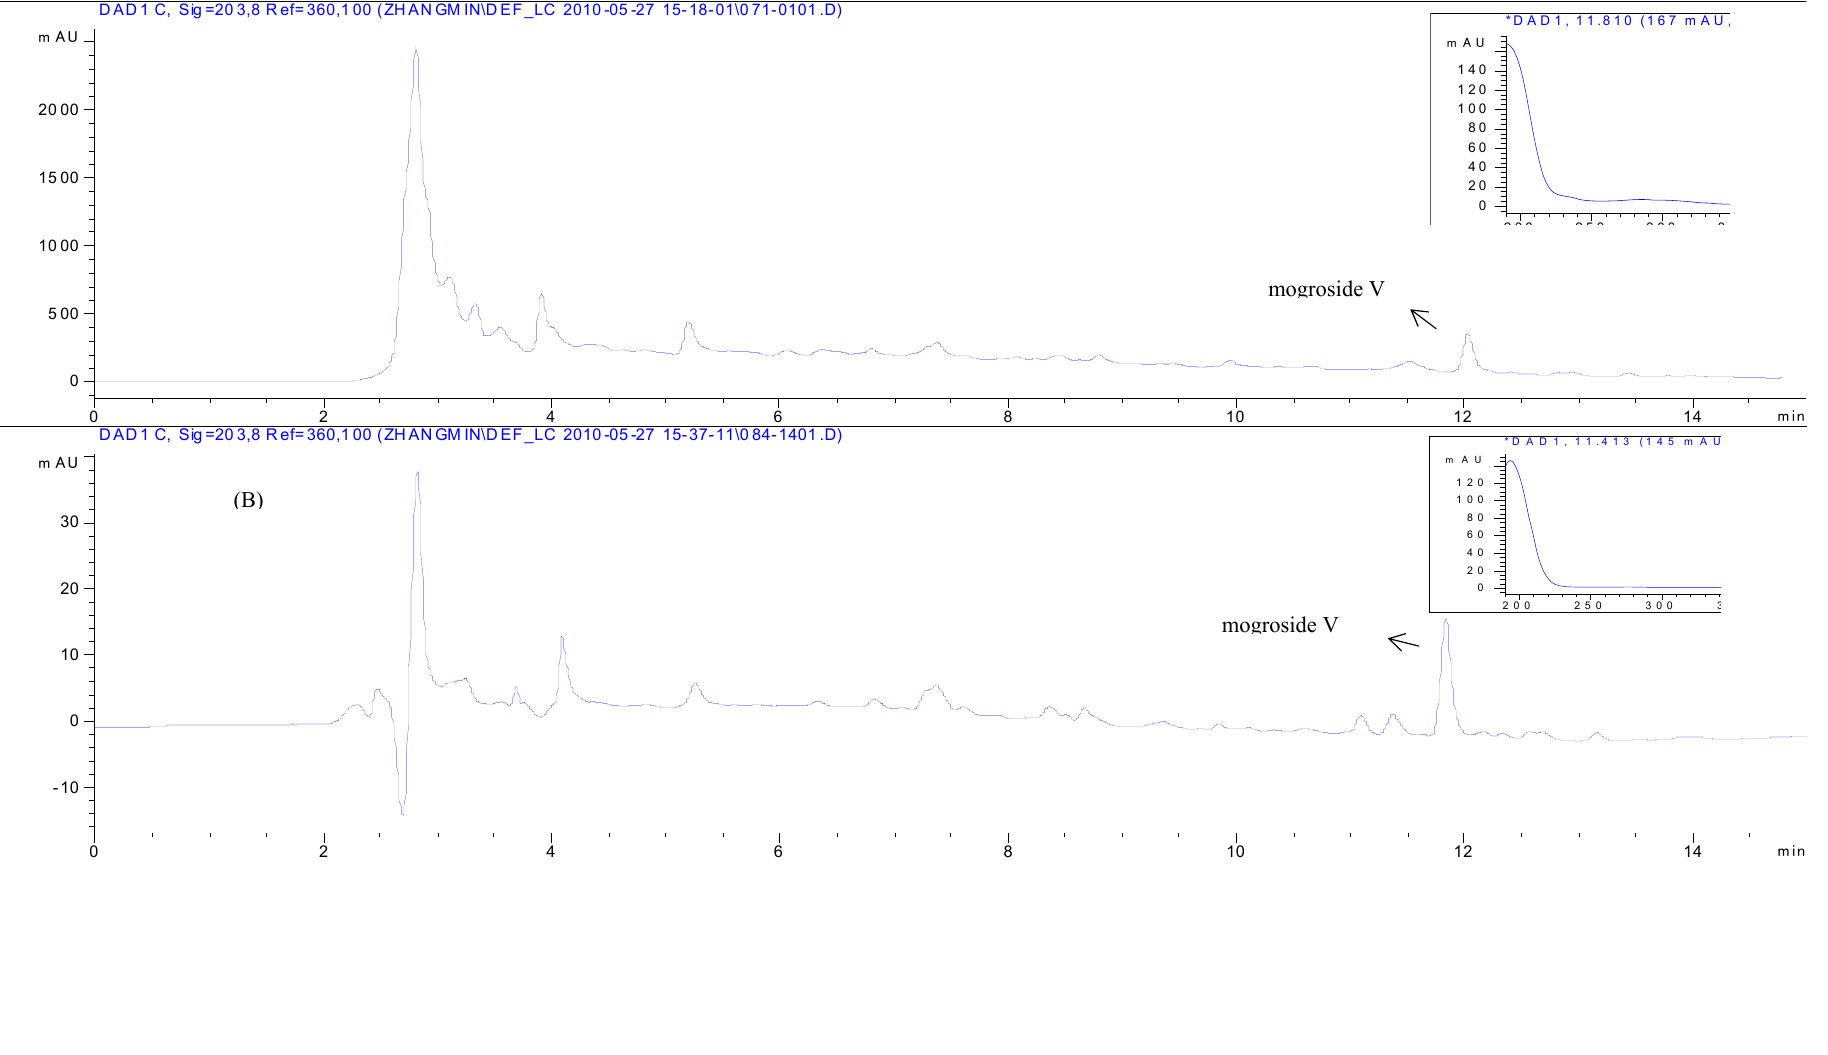
Figure 8. HPLC chromatograms of (A) S. grosvenorii and (B) purified mogroside